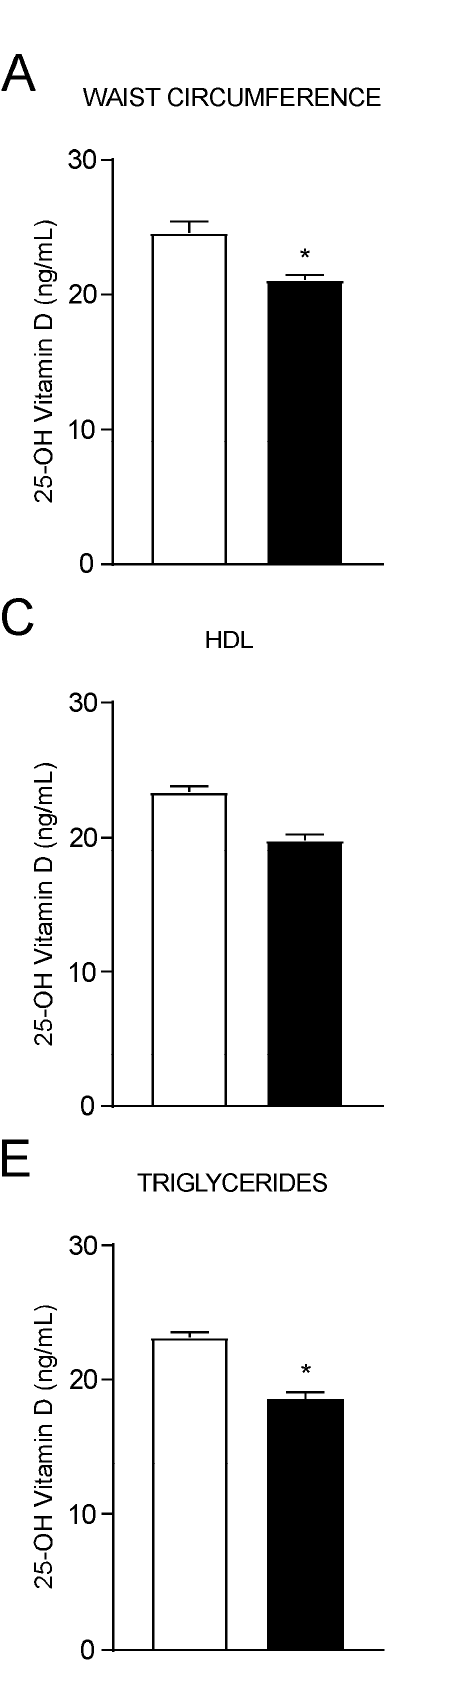
Figure 2. OH-25 vitamin D levels analysed by each MetS criterion. ( A – E ). T-Test comparison of OH-25 vitamin D values in subjects divided by positivity for each MetS criterion according to IDF definition. Data is presented as mean ± SEM. * p < 0.05.